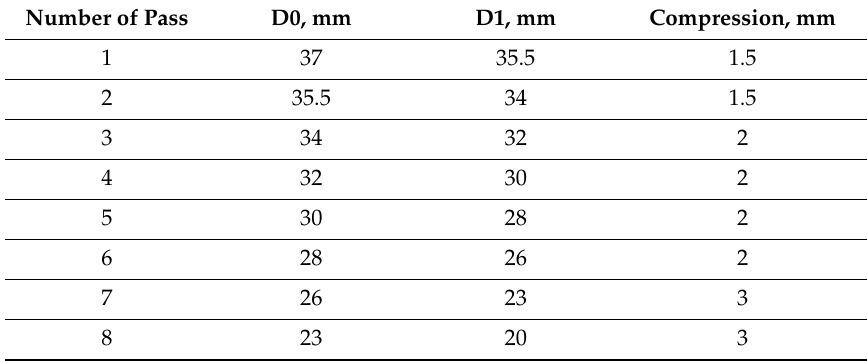
Table 1. Rolling parameters of zirconium bar with diameter of 37 mm on the SVP-08 mill.